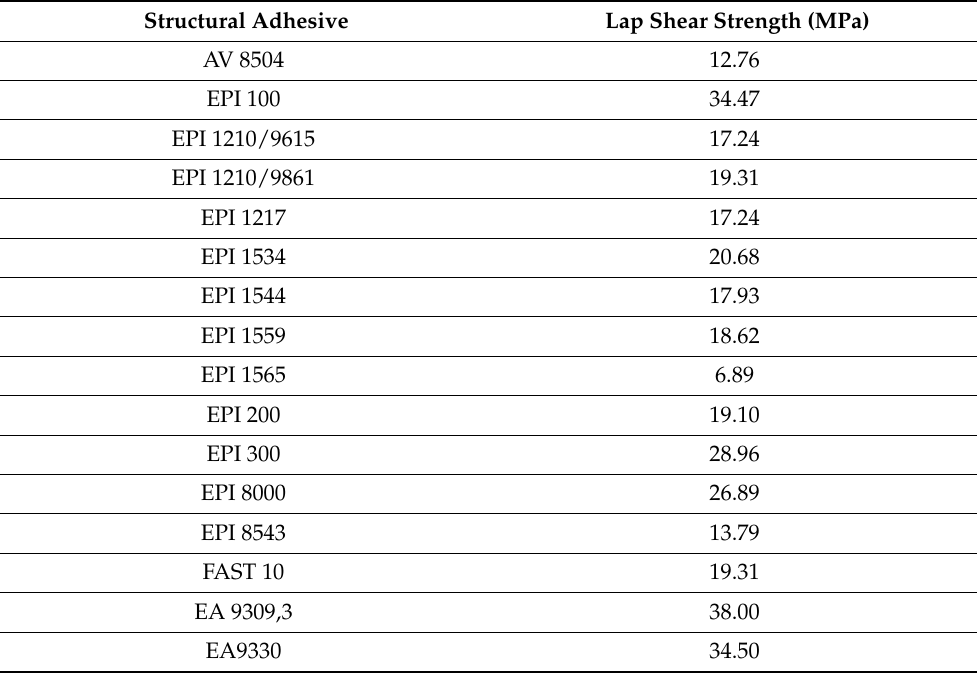
Table 10. Lap shear strength of structural